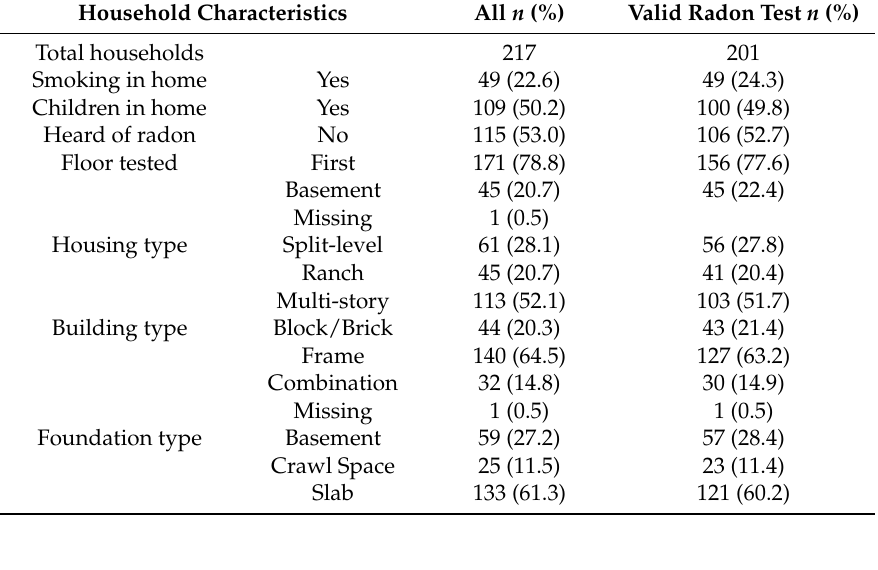
Table 2. Descriptive results of the homes tested in the DeKalb County pilot study in 2015.